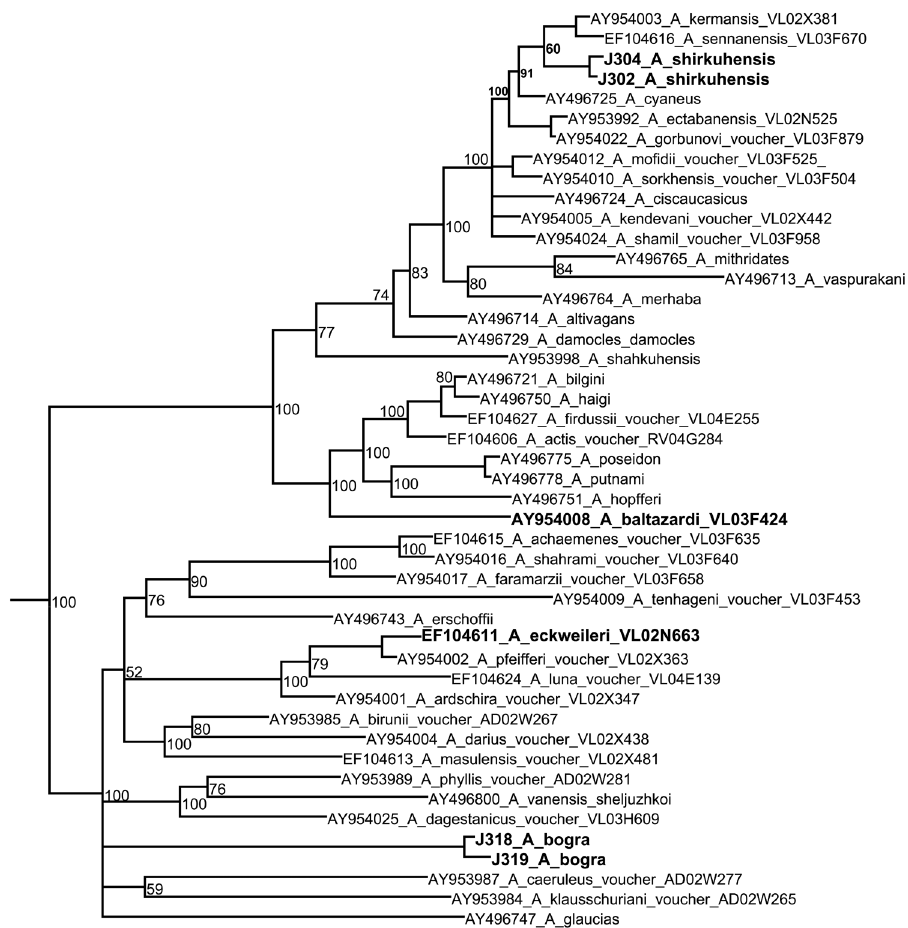
Figure 1. Fragment of consensus Bayesian tree of the subgenus Agrodiaetus inferred from COI sequences. Posterior probability values >50% are shown. Names of the target species are in bold. The complete tree is given online in the Suppl. material